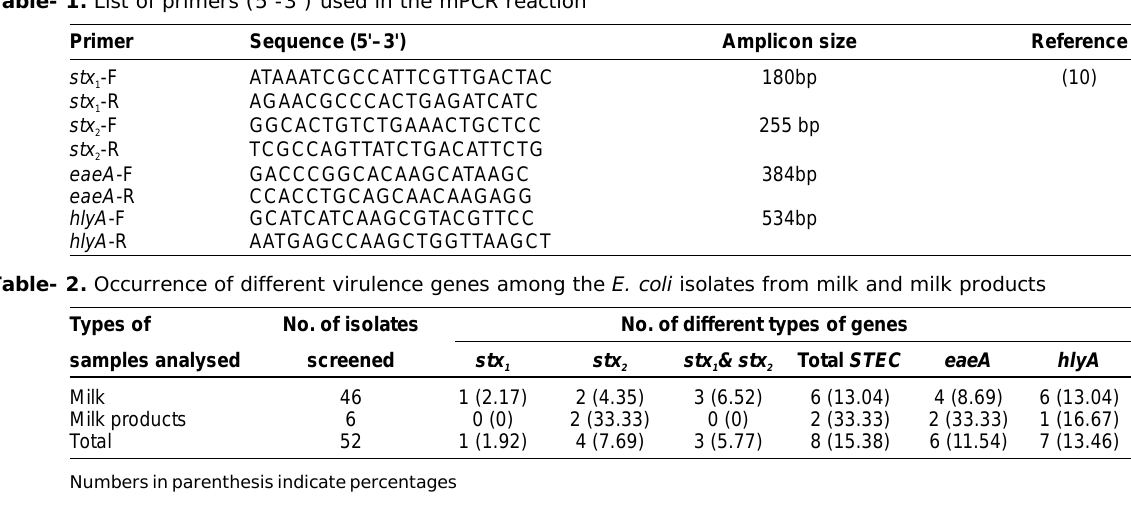
Figure-1. Agarose gel showing mPCR amplification products of stx , stx , eaeA and hlyA genes in E. coli